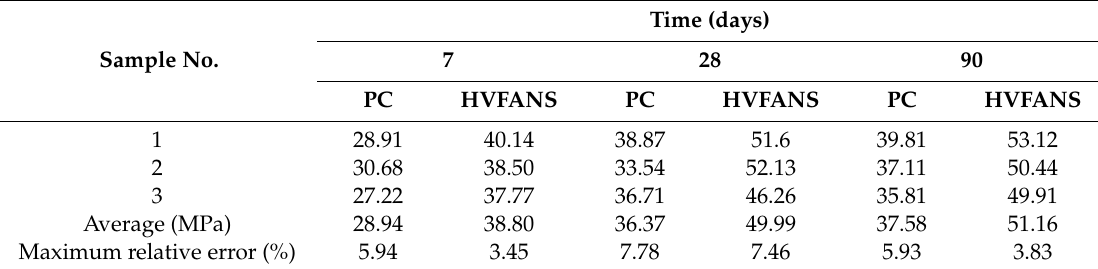
Table 4. Curing age e ff ect on the response of PC and HVFANS concrete at 700 ◦ C.